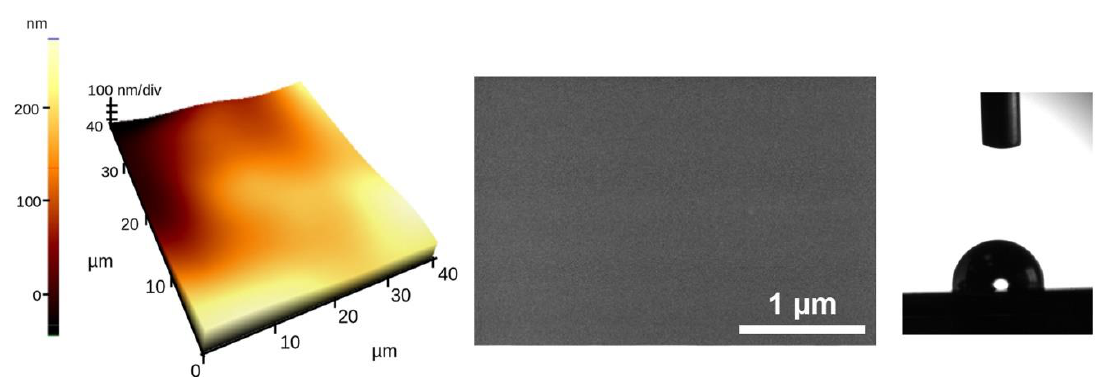
Figure 1. AFM and SEM images on a shellac film deposited from a 1 wt % shellac in a methanol frozen target on an Si substrate as a result of 72,000 pulses at a 266-nm wavelength with a fluence of 0.5 J/cm 2 . RMS roughness is 23 nm on 40 × 40 µ m 2 . The water contact angle is 97.2°.